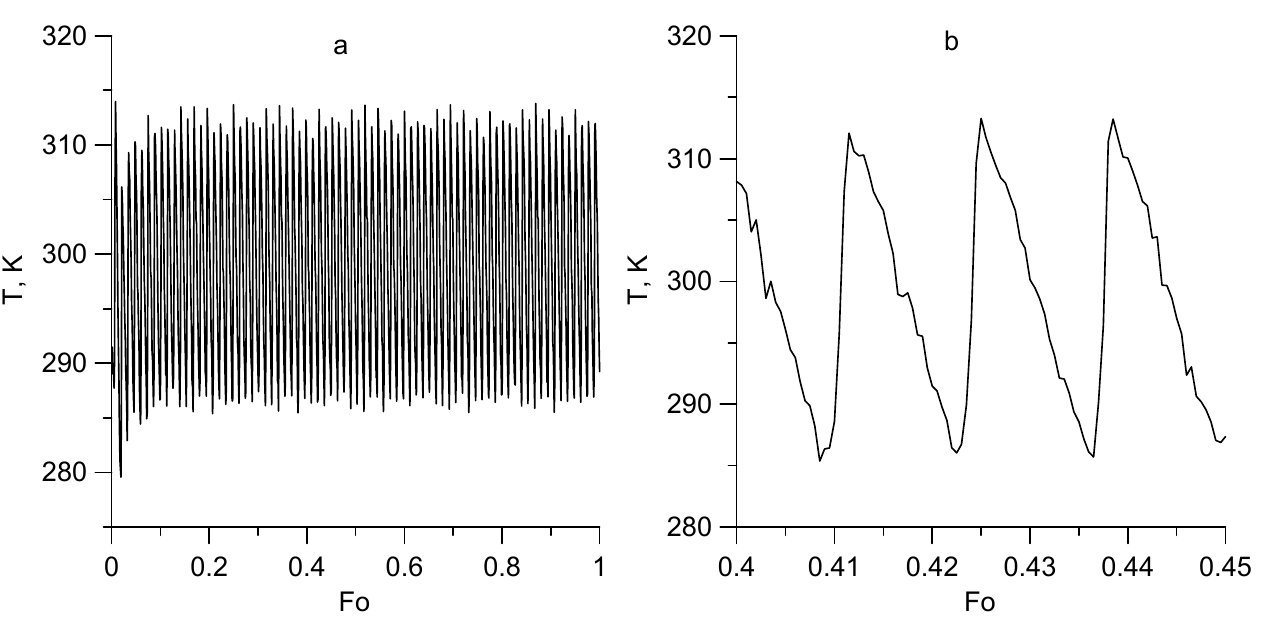
Figure 3. Temperature ( a ) and its image on a larger scale ( b ) at different moments of time at the point ξ = 0.8, θ = 0°, ζ = 0.5 for I = 173 without taking into account the linear term proportional to Fo. The characteristic non-monotonicity of the temperature over time should be noted.